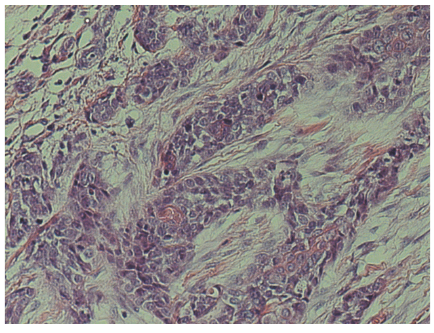
Figure 2: Haematoxylin and eosin (H&E) stain at × 40 magnifica- tion.